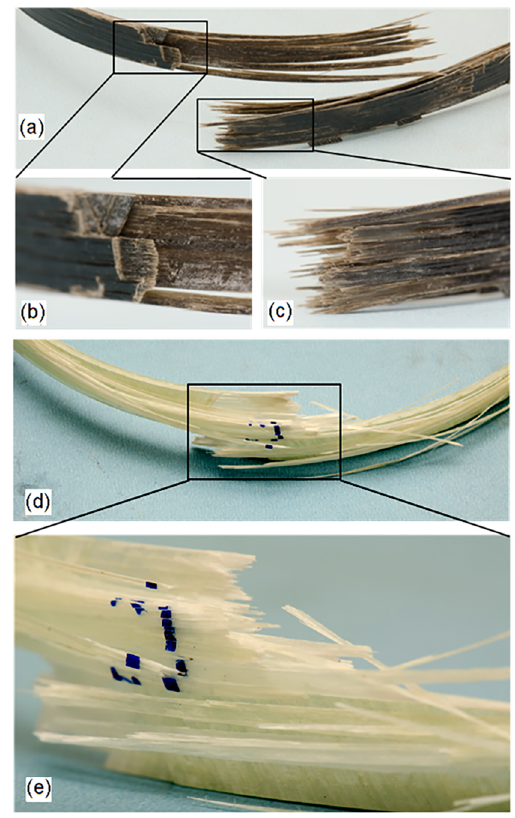
Figure 7. (a) BF and (d) GF ring segment specimen failure. Detail view of (b, c) BF and (e) GF